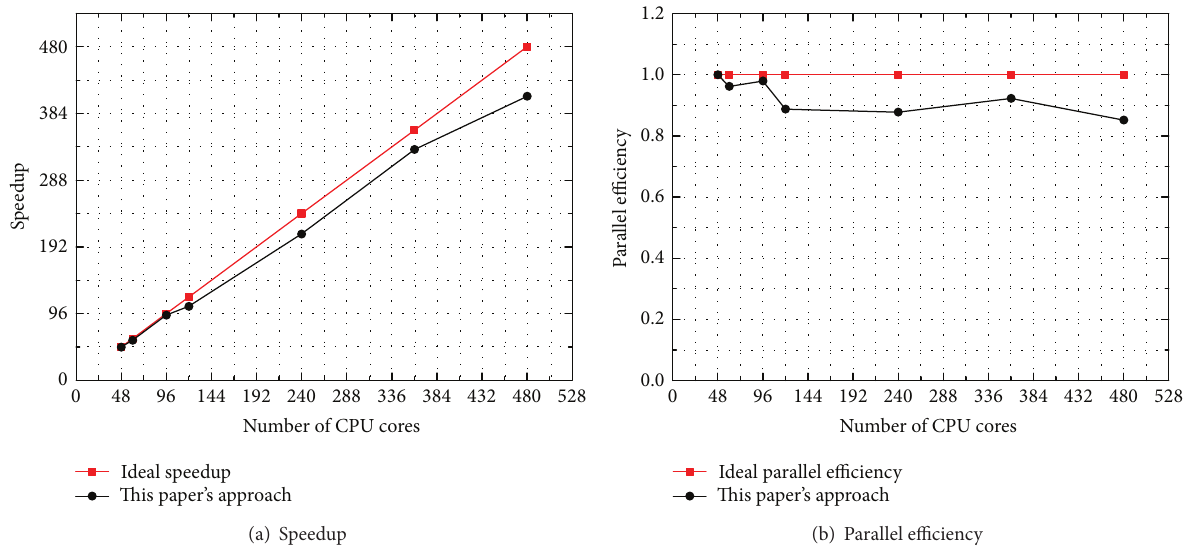
Figure 5: The speedup and parallel efficiency of the code from 48 CPU cores to 480 CPU cores on NSCC-SZ.